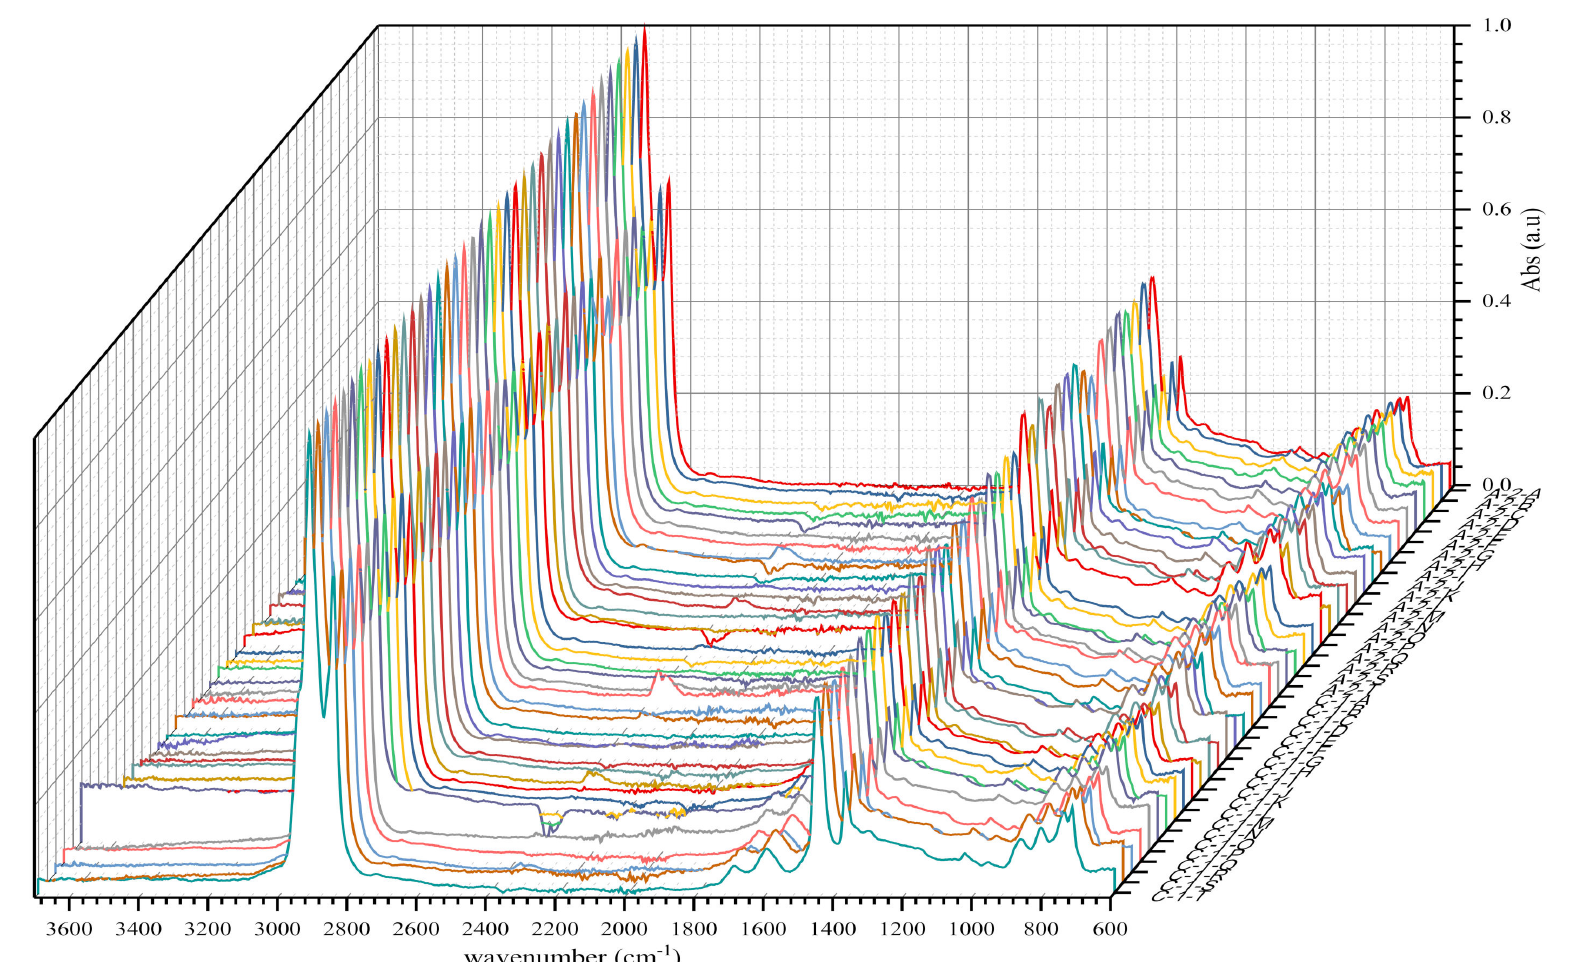
Figure 6. IR spectra of BND 100/130 from plants A and C before short-term ageing